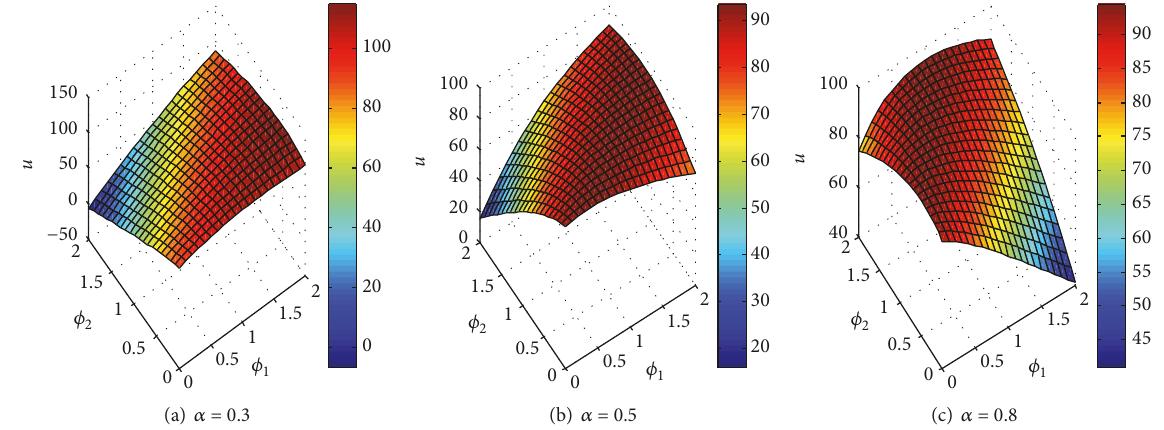
Figure 11: The impact of fairness concern on the total expected utility u